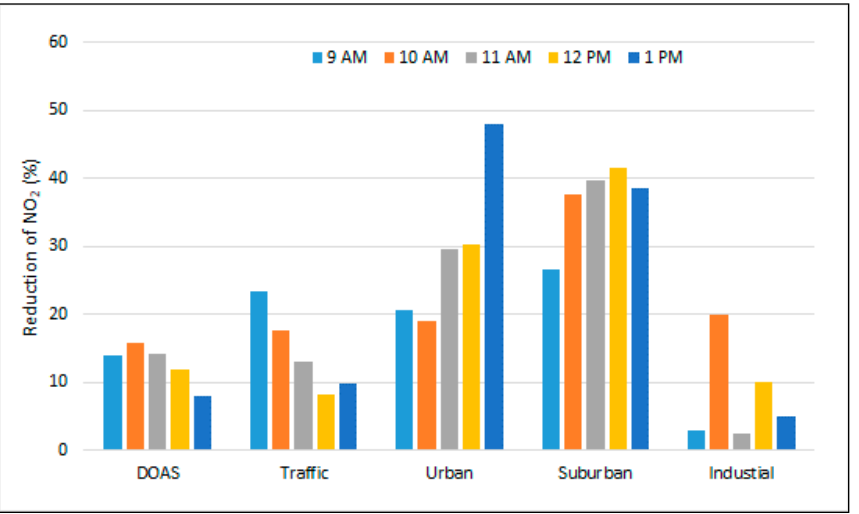
Figure 9. Decrease in NO 2 content for each hour between 9 and 13 LT in 2 April 2020 (during lockdown), relative to 11 February 2020 (before lockdown), seen in mobile DOAS measurements and in local concentrations measured at the four